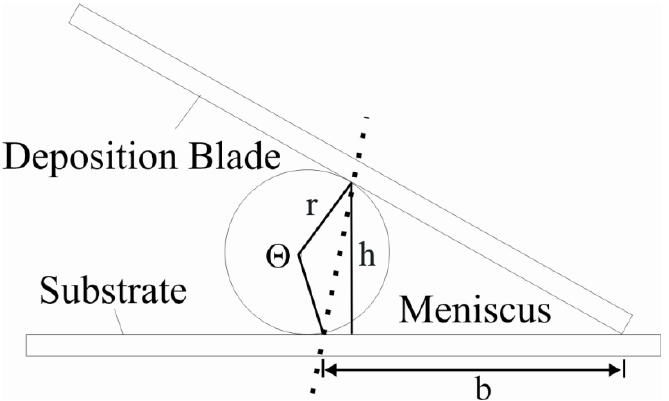
Figure 10. Schematic of meniscus shape geometry used in the volume